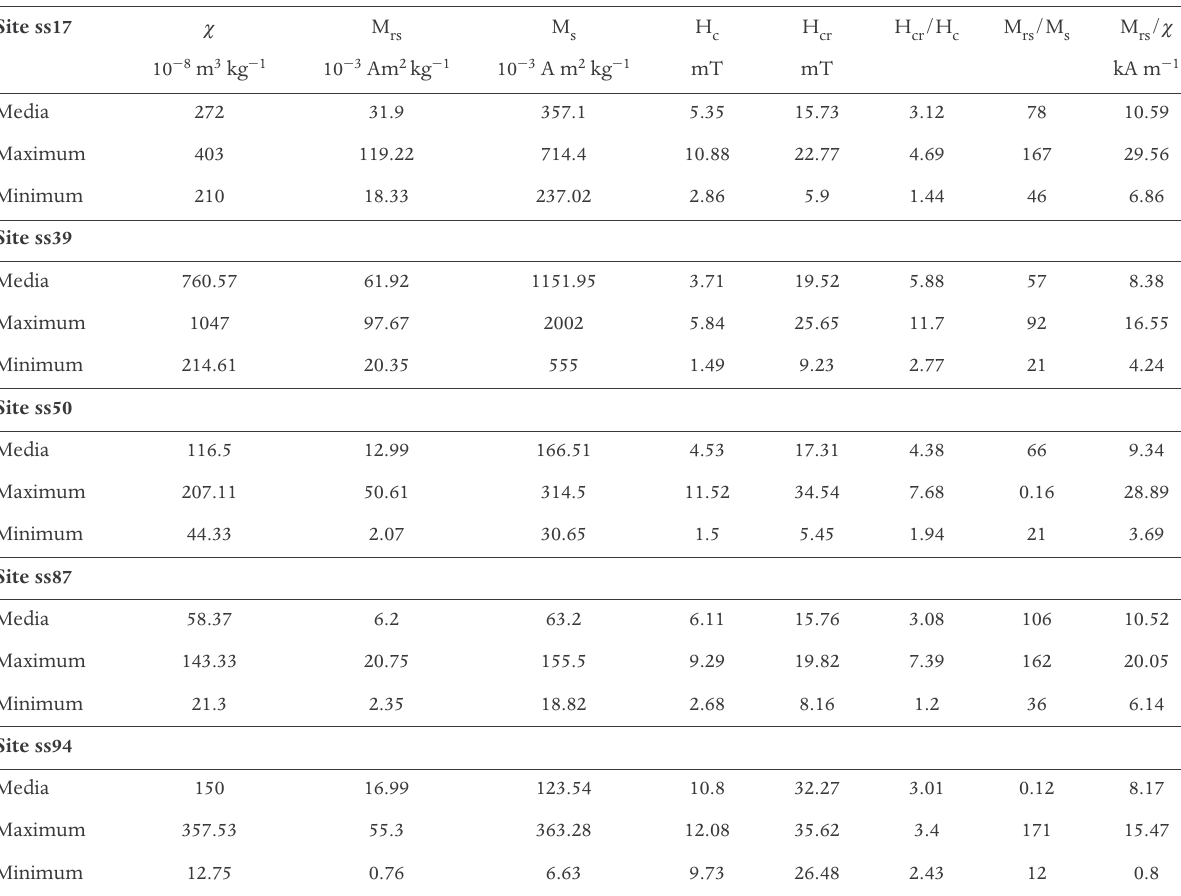
Table 1. Statistical values of magnetic